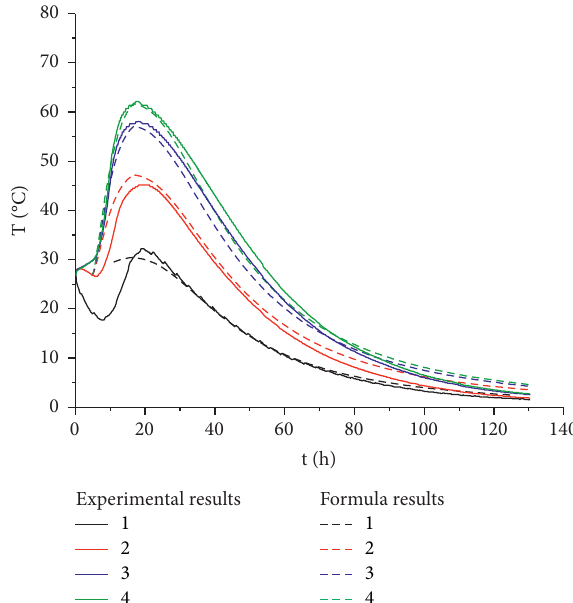
Figure 14: Comparison of experimental and formula-calculated results for the 1.4-m diameter CFST member.